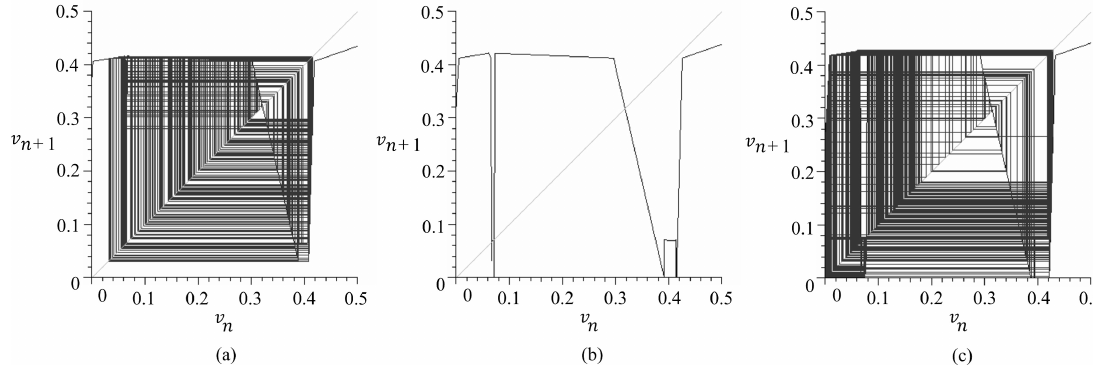
Figure 19. Iterative paths with the initial point: v 0 = 0.5. ( a ) ξ = 0.1. ( b ) ξ = 0.2. ( c ) ξ = 0.3.